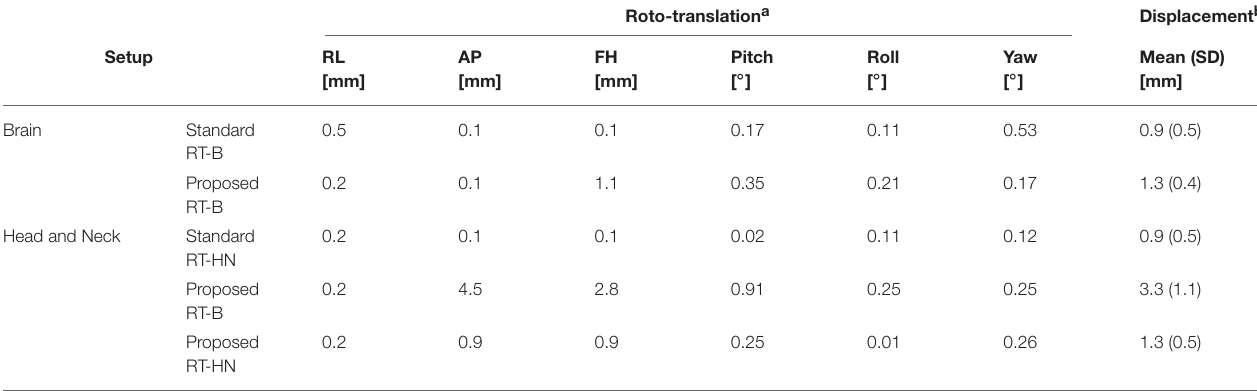
TABLE 1 | Inter-fraction subject repositioning accuracy for the standard and the proposed RT-B (upper rows) and RT-HN (lower rows) setups.